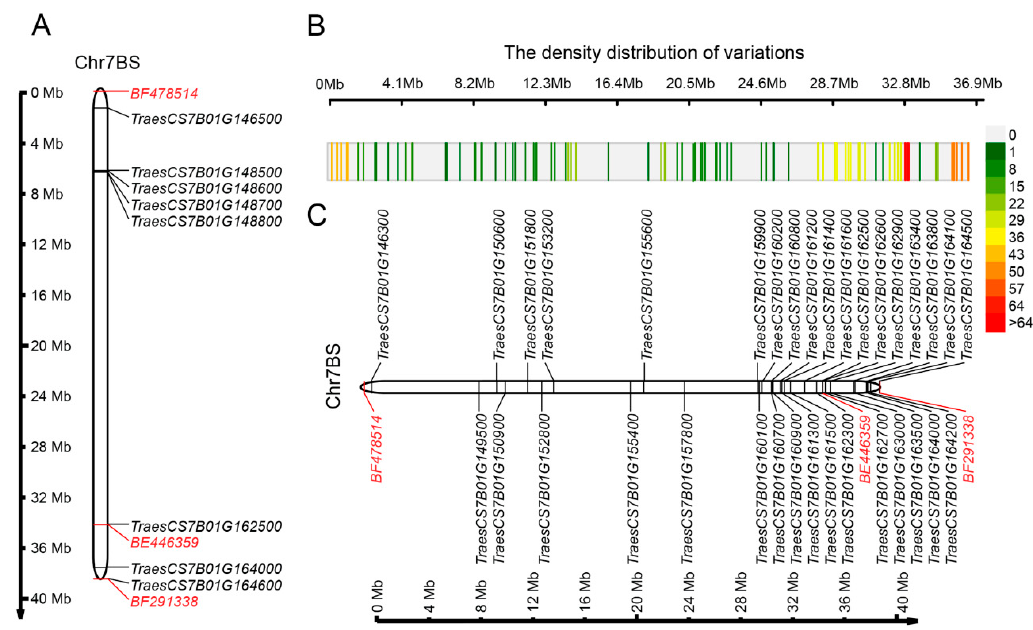
Figure 2. Distributions of NLR and RLK genes, identified variants, and the genes containing variations. ( A ) The physical locations of 7 RLK genes and 1 NLR gene in the Pm40 mapping region. ( B ) Variants were distributed in the mapping interval of Pm40 . The distribution of genes containing variants that may have an effect on the gene. ( C ) The distribution of genes that have variants that may affect the genes. Table 2. The effects of genetic variations in the Pm40 region predicted by mutation